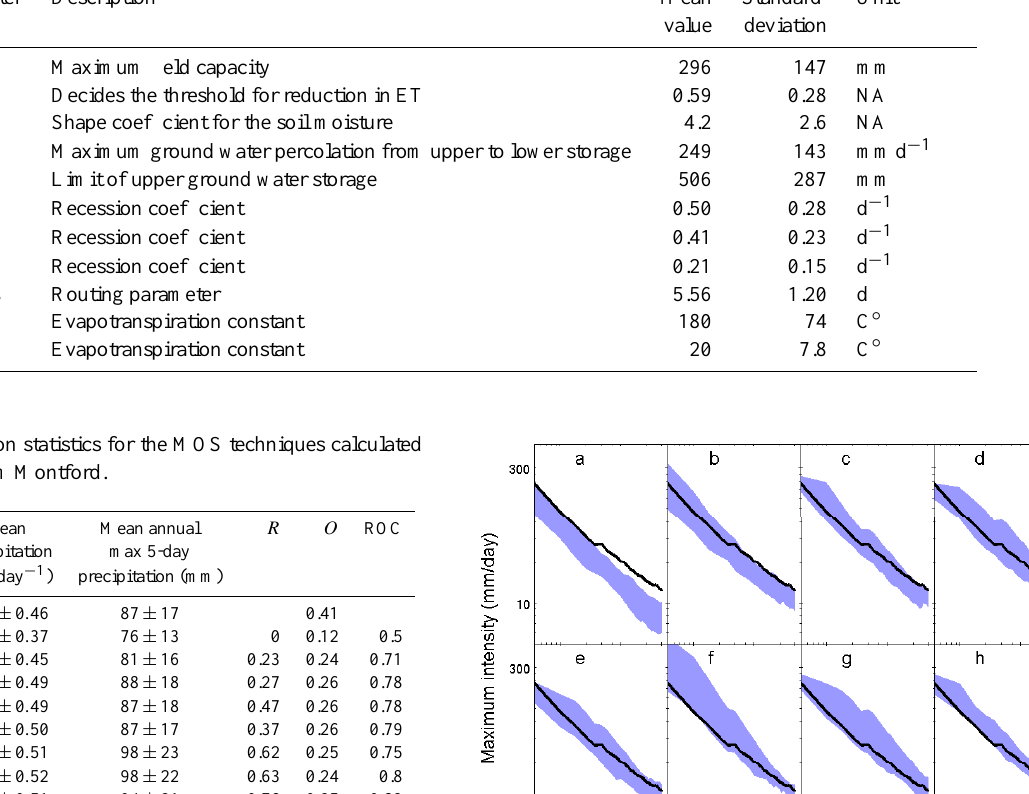
Table 1. Range of parameter values derived during the calibration of the HBV model. Parameter definitions follow those of Seibert (1997). Parameter Description